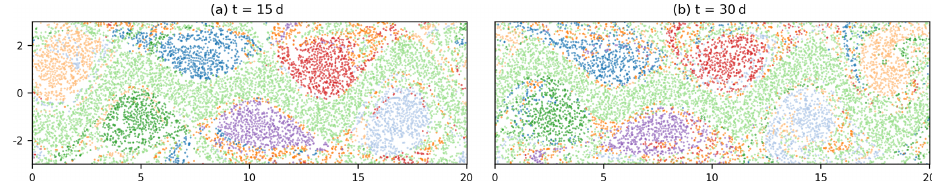
Figure 5. Result of K = 8 k -means clustering of the 2D embedding from classical MDS (see Fig. 4). Axis units are in